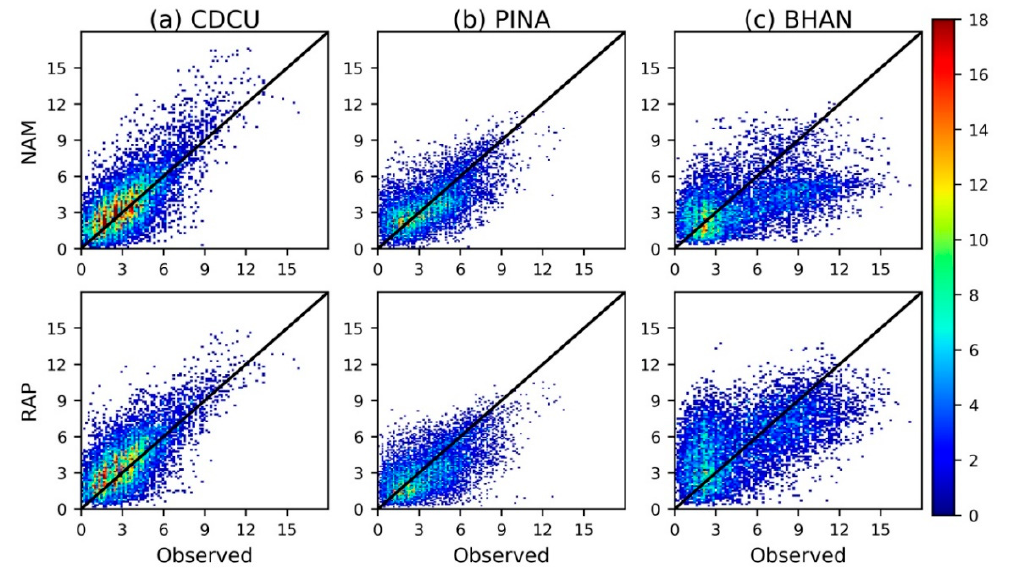
Figure 10. Comparisons between the 10 m wind speed between observations and NAM and RAP models in 2013 for ( a ) CDCU (1.1 < σ < 0.9), ( b ) PINA ( σ ~0.8), ( c ) BHAN ( σ ≤ 0.75). The number of occurrences are shown in shaded.